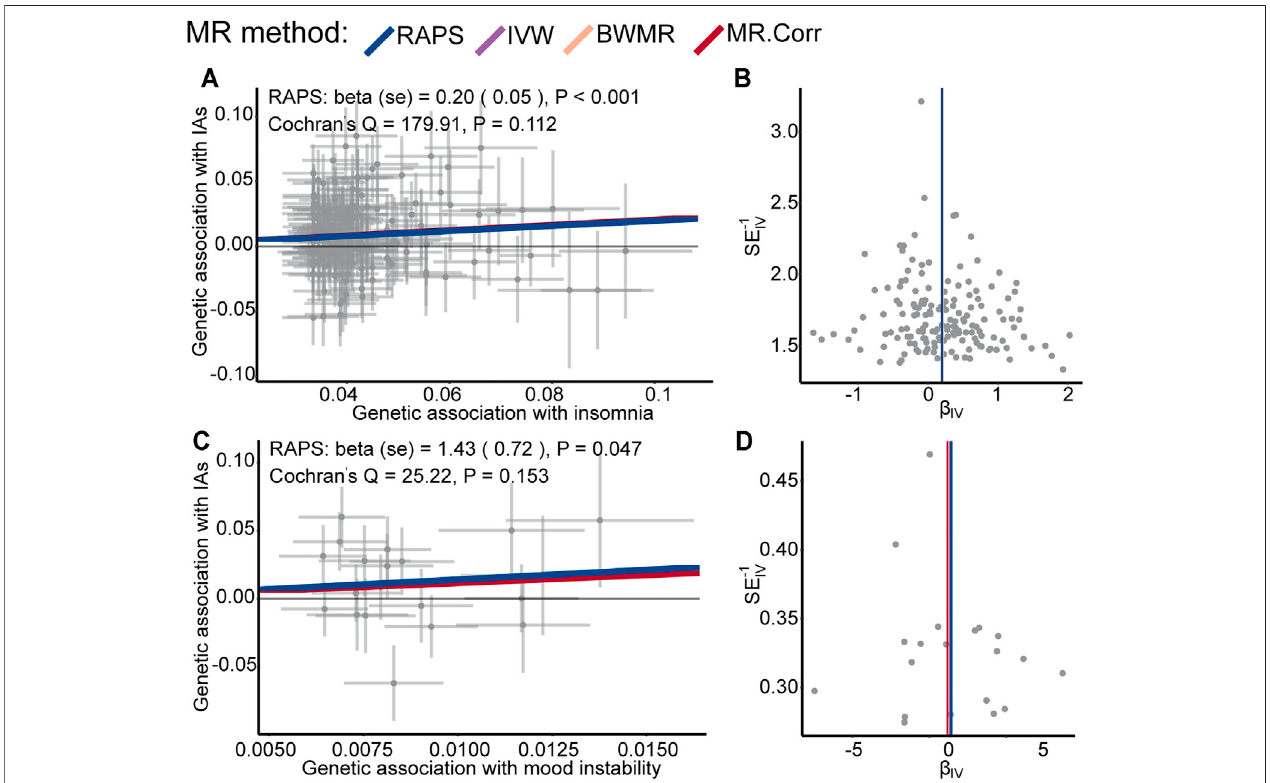
FIGURE 2 | Scatter plots of SNPs with IAs versus. SNPs with insomnia (A) and mood instability (C) for all the valid IVs. Each dot represents one SNP, with corresponding standard error bars of its relation to insomnia, mood instability ( y -axis) and IAs ( x -axis); the colored solid lines represent estimated causal effect values of four MR methods. Funnel plots of the causal effect point estimate about insomnia (B) and mood instability (D) on IAs displaying a symmetric shape; The vertical colored lines represent the estimated causal effect acquired utilizing all